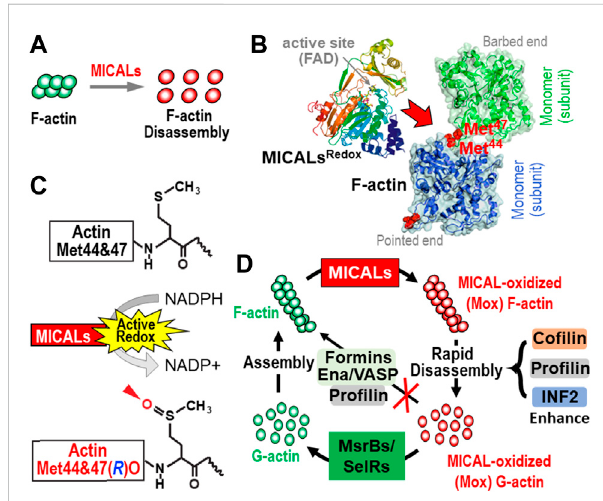
The MICAL ’ s activity and its effects on actin dynamics. (A – C) MICALs posttranslationally modify speci fi c methionine (Met) residues in F-actin (red), which triggers F-actin disassembly (A) . More speci fi cally, MICALs bind to F-actin [ (B) , red arrow)] and in the presence of their coenzyme, NADPH (C) , selectively and stereospeci fi cally oxidize (O) actin ’ s Met44 and Met47 in the R -conformation [ (C) , arrowhead]. This oxidation of Met44 and Met47 [see (B) , red] occurs in the D-loop, at the pointed end of individual actin fi lament subunits, which disrupts the interprotomers interactions inF-actin andleads totheirrapiddisassembly. (D) MICAL- mediated F-actin disassemblyis regulated by otherproteins.From top and clockwise: following MICALs ’ oxidation of F-actin to generate MICAL-oxidized (Mox) F-actin, MICAL-triggered F-actin disassembly is enhanced by other proteins, including co fi lin, pro fi lin, and INF2. The Mox-G-actinthatisformeddoesnotreadilyre-polymerizeeveninthe presence of pro fi lin, formins, and Ena/VASP. Yet, Mox-G-actin is reduced speci fi cally by selective methionine sulfoxide reductases (MsrBs/SelRs), and this G-actin can then re-polymerize normally. In thisway,MICALsandMsrBs/SelRscreateareversiblesystemforRedox regulation of actin dynamics in